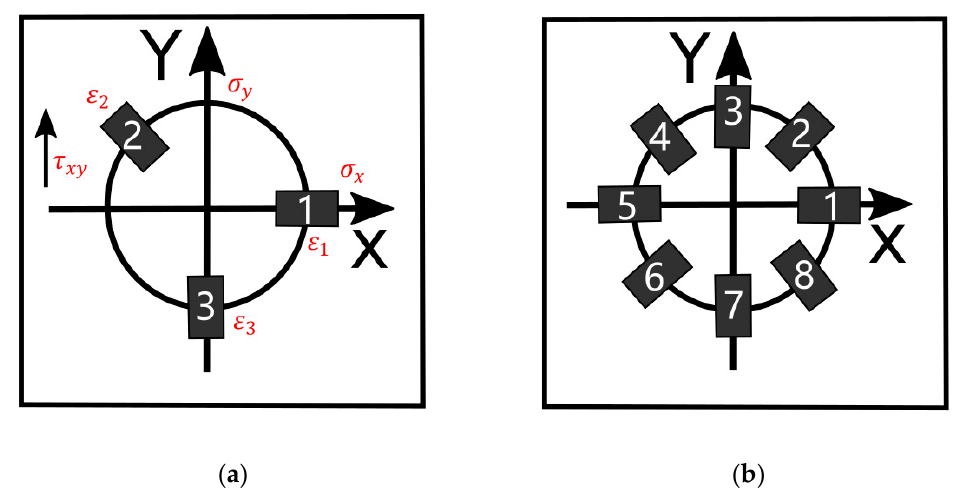
Figure 2. Schematic of ( a ) a typical three-element strain gauge with corresponding coordinate system and ( b ) a special strain gauge rosette with eight grids used for strain measurement in the present work.